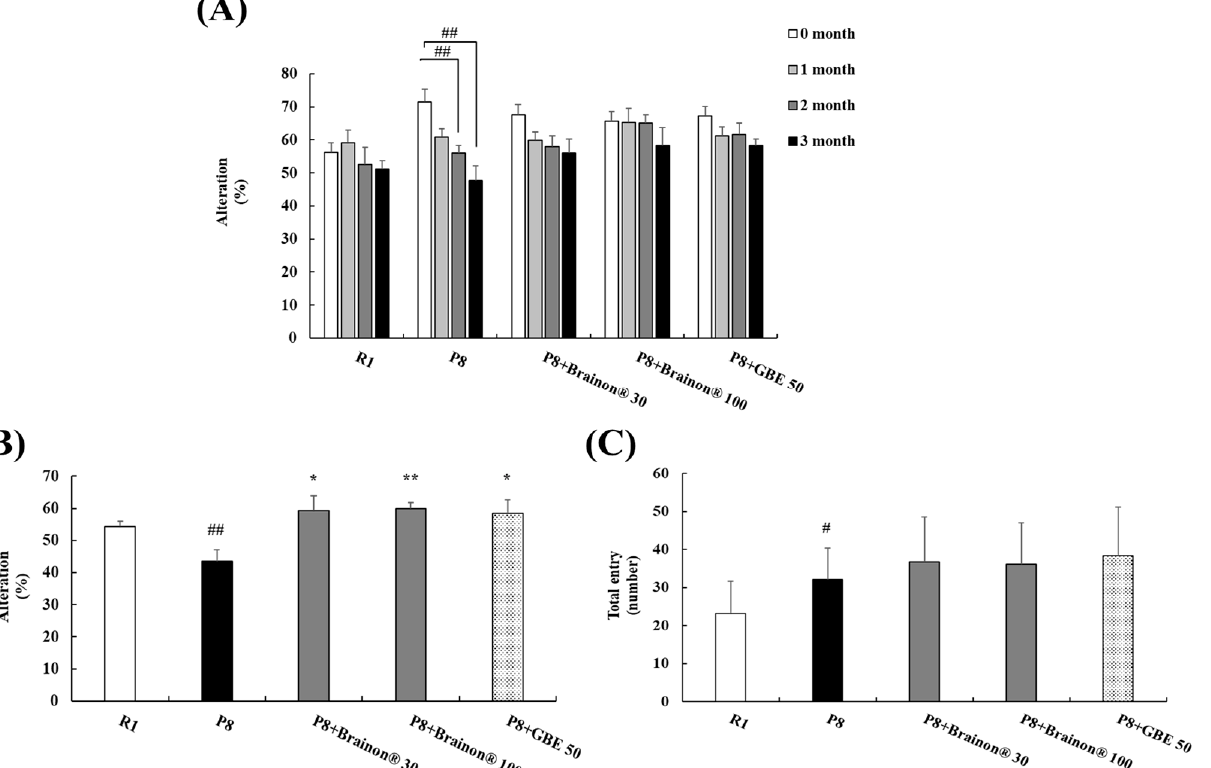
Figure 3. Brainon ® prevents age-dependent cognitive declines of SAMP8 mice in the Y-maze test. ( A ) SAMP8 considerably reduced the level of spontaneous alternation over the time period. ( B ) The average spontaneous alternation rate. ( C ) The number of total arm entries between SAMP8 group and Brainon ® group or GBE group were not statistically different. Data are expressed as mean ± SD of independent experiments ( n = 6). # p < 0.05 and ## p < 0.01 vs. R1 (SAMR1) group; * p < 0.05 and ** p < 0.01 vs. P8 (SAMP8) group.